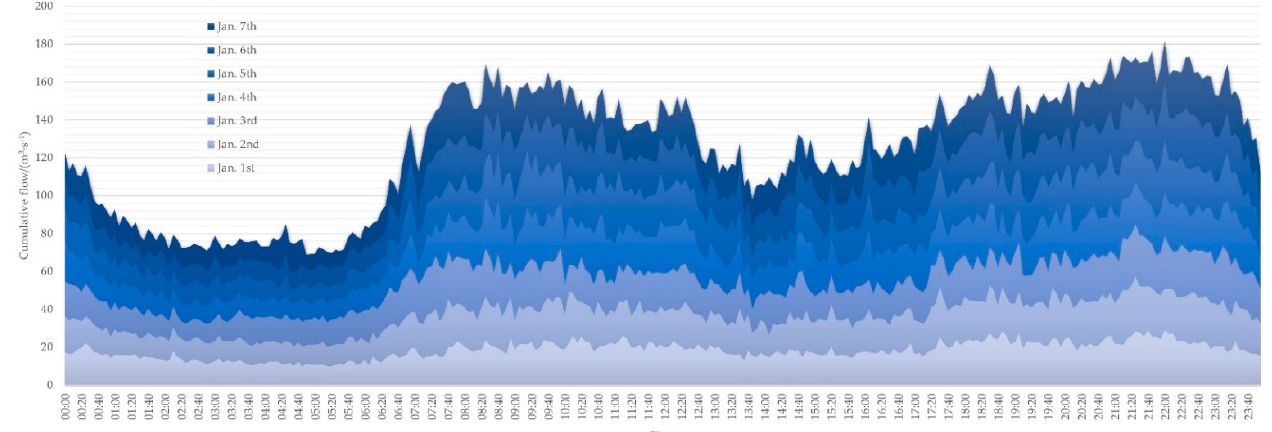
Figure 7. Q - t stacking area map .